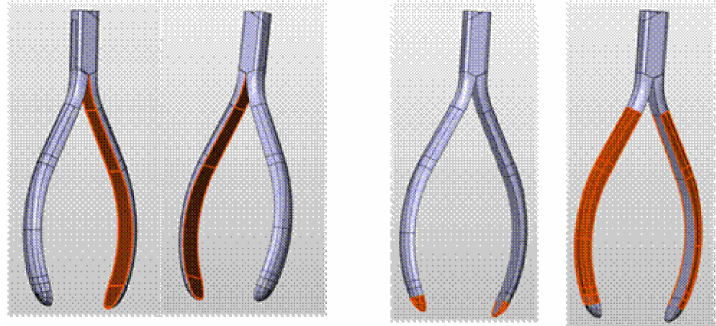
Figure 4. The processed surfaces of the forceps: all red marked